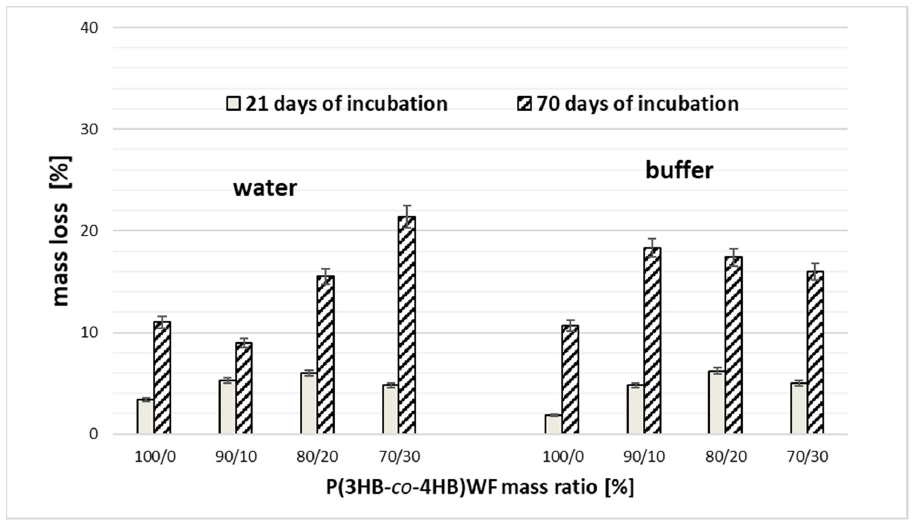
Figure 5. Mass loss of neat P(3HB- co -4HB) and P(3HB- co -4HB)/WF composites after 21 and 70 days of degradation.